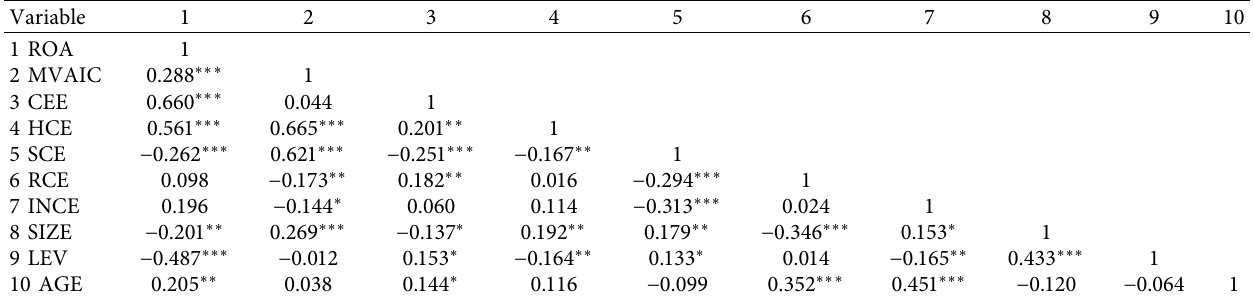
Table 3: Correlation